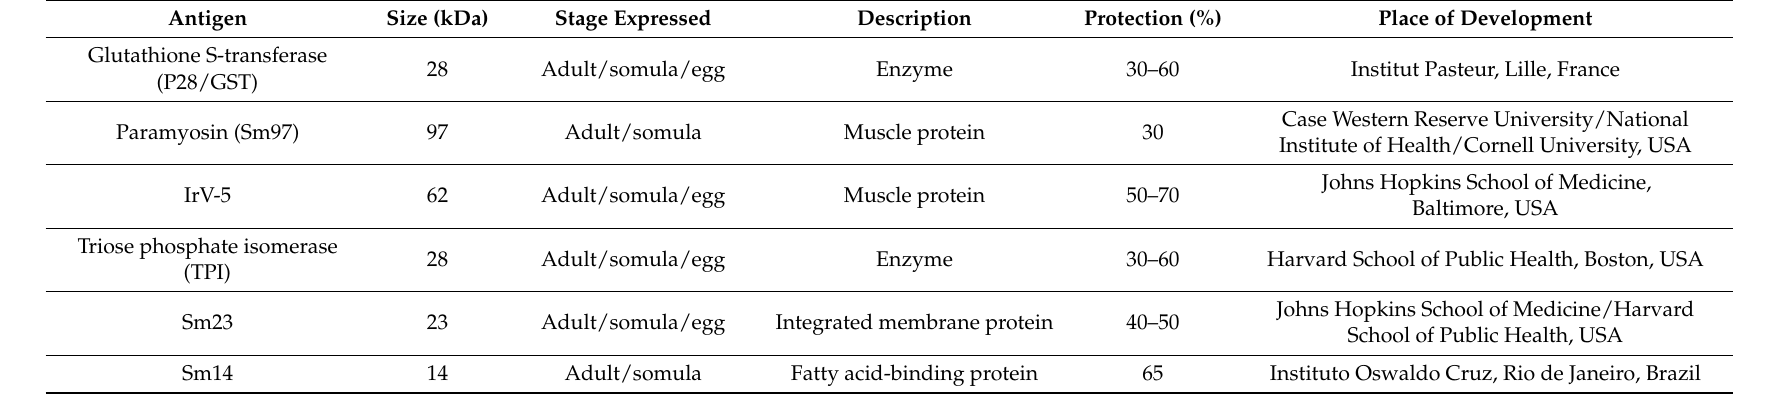
Table 1. Schistosomiasis priority antigens selected by the WHO for independent testing (adapted from